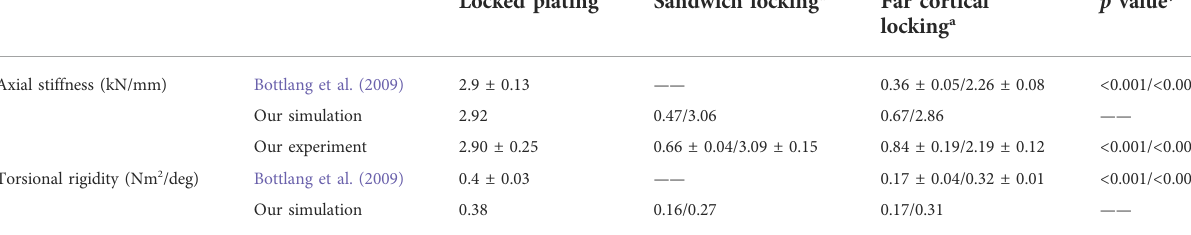
TABLE 2 The stiffness results of each group of experiments under axial compression (0 – 1000 N) and torsion (0 – 10 Nm) loading